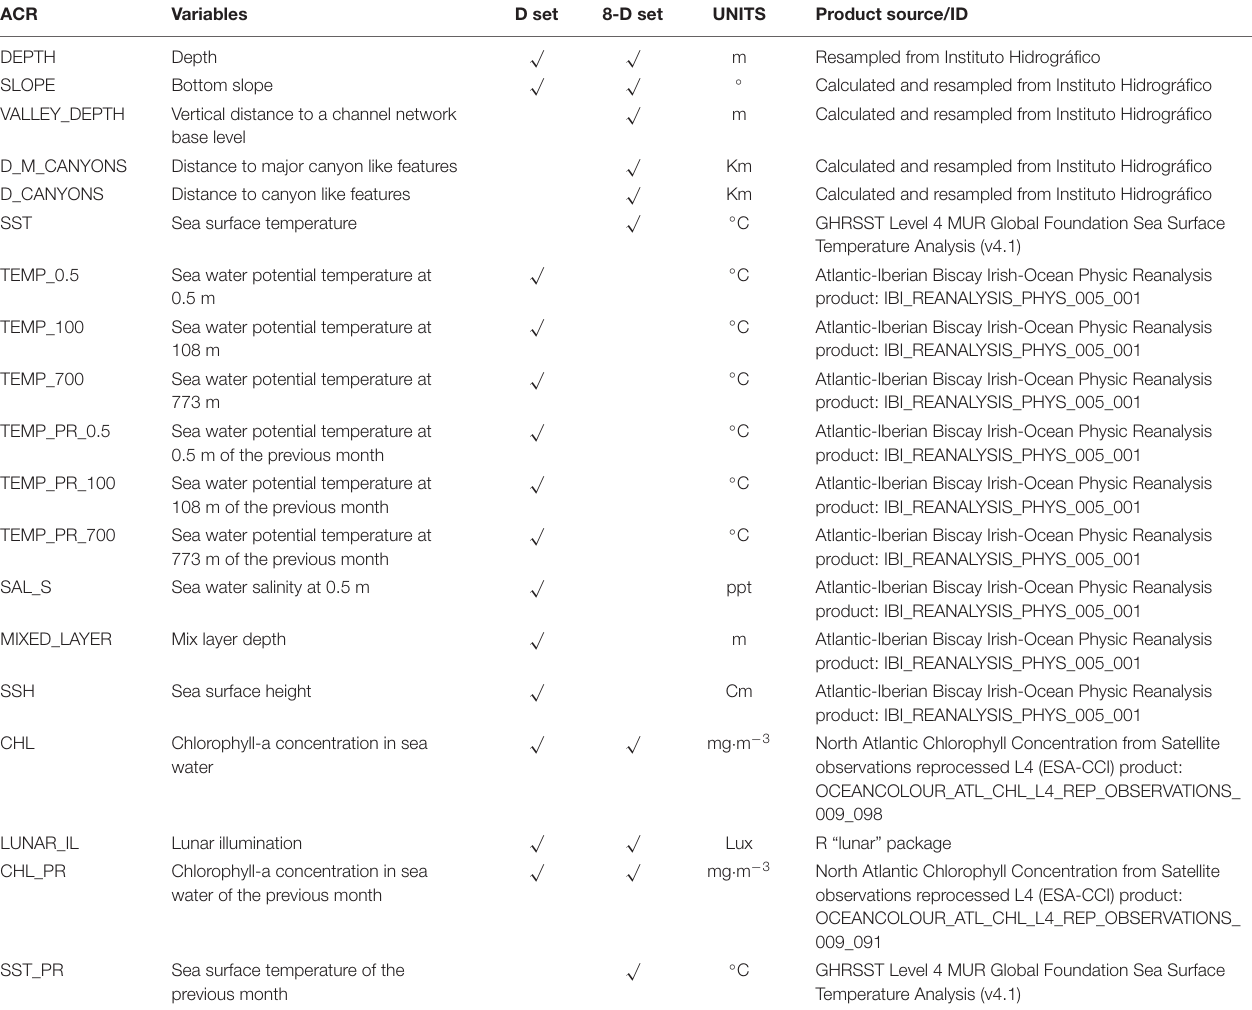
TABLE 2 | Variables used to construct the two different assemblages of layers for the present analysis: the (1) “D” set with a spatial resolution of 7.8 km and a temporal resolution of 1 day, and the (2) “8-D” set, with a spatial resolution of 2 km and a temporal resolution of 8-days and 1 month. ACR Variables D set 8-D